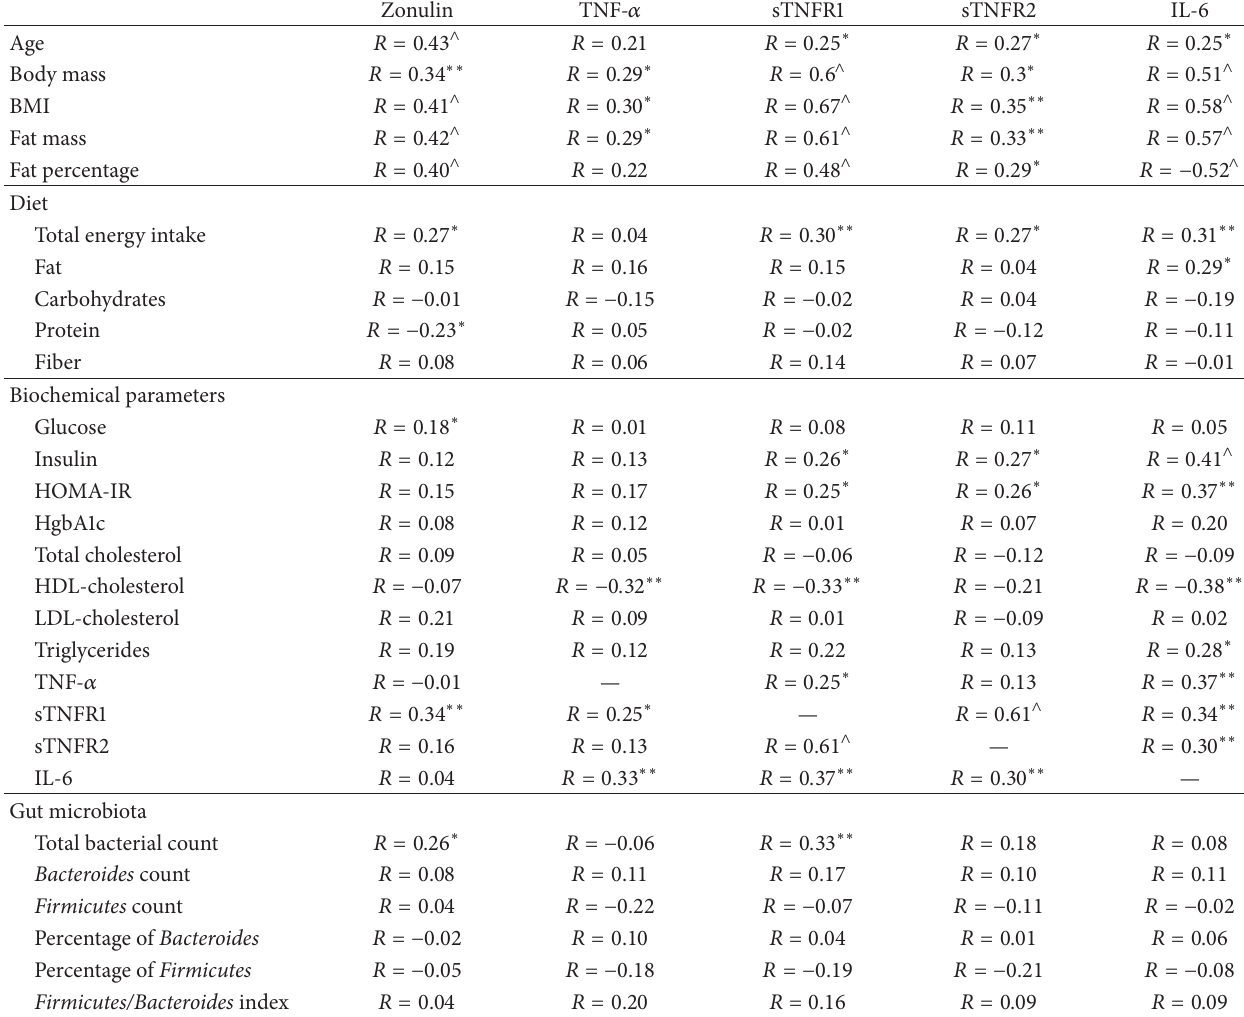
Table 4: The univariate correlations of study parameters in the whole group of